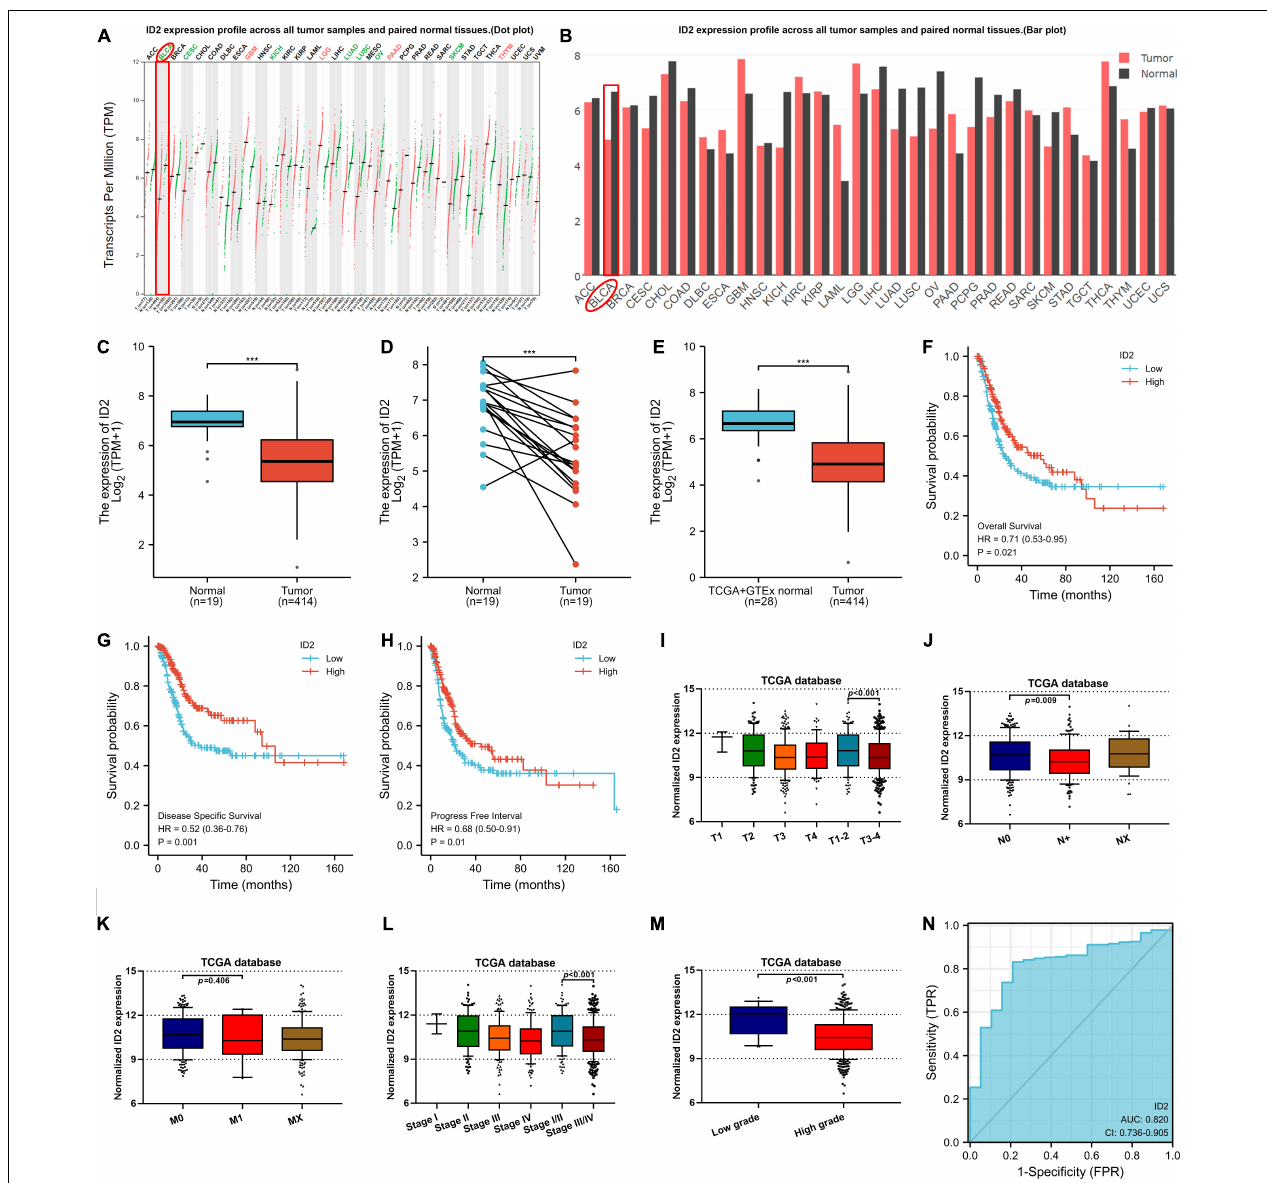
FIGURE 1 | ID2 expression correlates with clinical characteristics and survival rate in the TCGA database. (A,B) ID2 expression profile across all tumor samples and paired normal tissues. (C) The difference expression of ID2 in BCa tissues and adjacent normal tissues. (D) The difference expression of ID2 in BCa tissues and paired normal tissues. (E) The difference expression of ID2 in normal tissues of GTEx combined with TCGA and BCa tissues of TCGA. (F–H) Overall survival (F) , disease-specific survival (G) , and progress free interval (H) curve of BCa patients with low ( n = 207) and high ( n = 207) ID2 expression. (I–M) Relative expression levels of ID2 in TCGA database with T stage (I) , N stage (J) , M stage (K) , pathological stage (L) , tumor grade (M) . (N) ROC curve showed the efficiency of ID2 expression level to distinguishing BCa tissue from non-tumor tissue (*** p < 0.001).